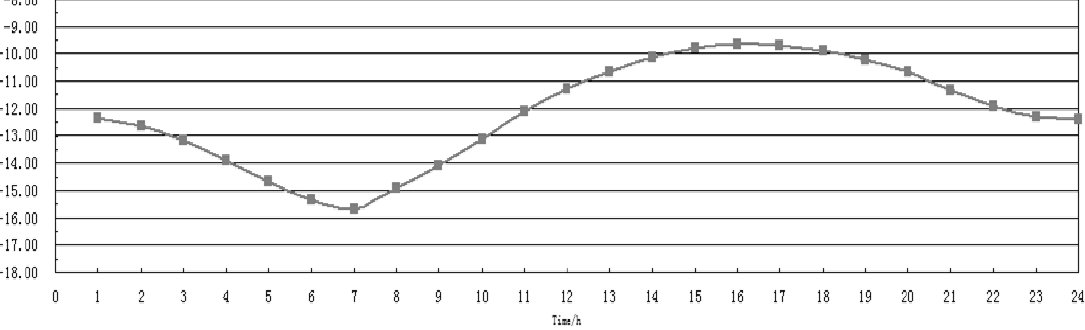
Figure 5. Temperature meteorological model of particular day of disastrous weather in July in Beijing.